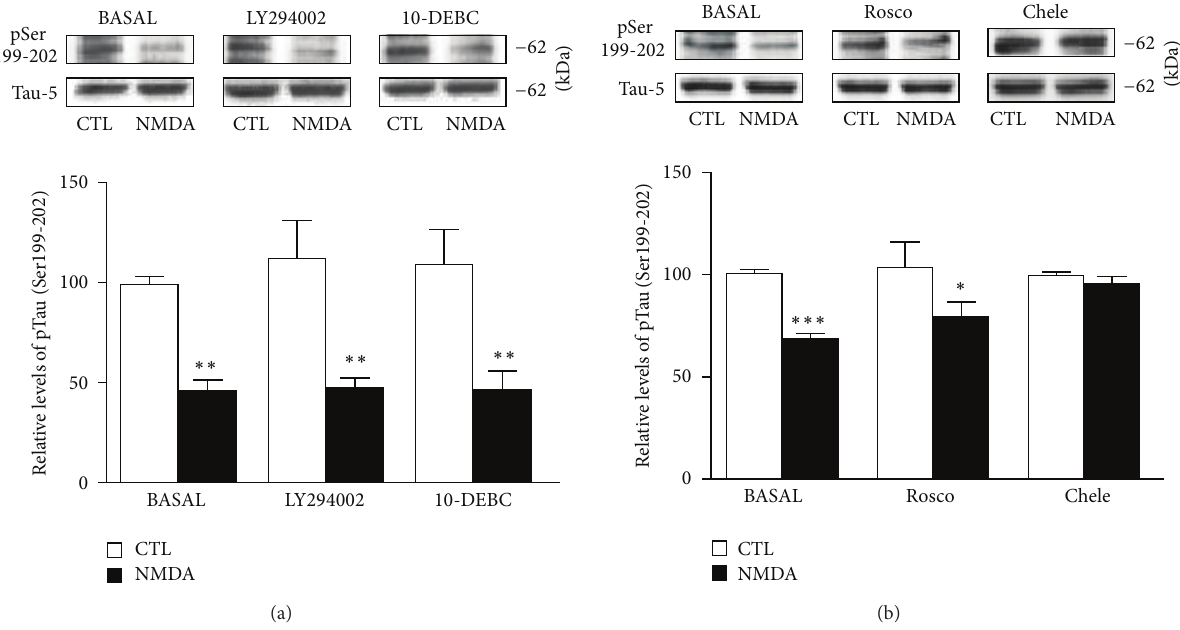
Figure 6: NMDA-induced changes in Tau phosphorylation require PKC activation. (a) Phosphorylated Tau levels at Ser199-202 were estimated by Western blotting of cell extracts obtained from hippocampal slices treated with 10 𝜇 M NMDA for 1 hour alone or in combination with the Akt/PKB inhibitor 10-DEBC hydrochloride (10-DEBC; 2.5 𝜇 M) and the PI3K inhibitor LY294002 (10 𝜇 M). The data are expressed relative to total Tau (i.e., Tau-5) levels. (b) As in (a), except that the cdk5 inhibitor Roscovitine (Rosco; 10 𝜇 M) and the global PKC inhibitor Chelerythrine chloride (Chele; 1 𝜇 M) were employed. The data are expressed as percentages of control values and are means ± S.E.M. of 3 measurements per cell extract obtained from 6 different rats. For statistical analysis, one-way ANOVA was followed by Newman-Keuls